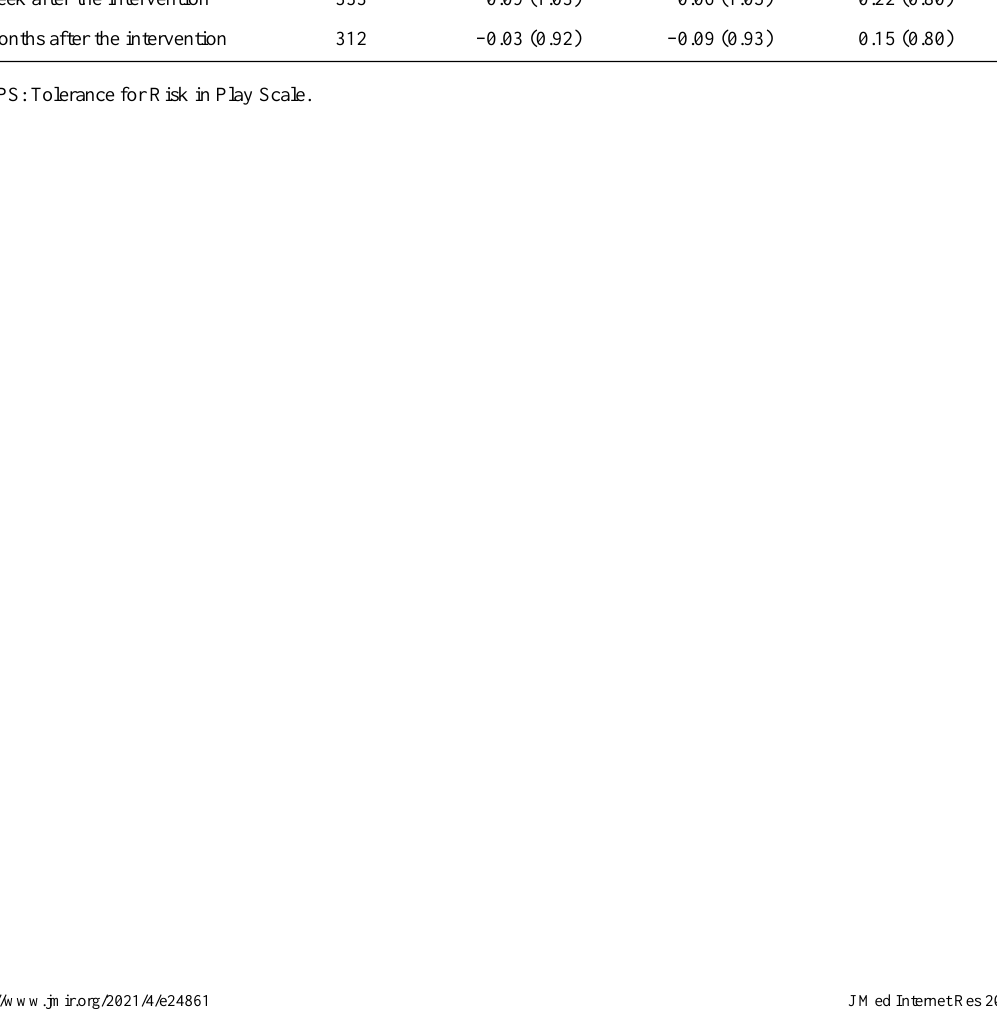
a TRiPS: Tolerance for Risk in Play